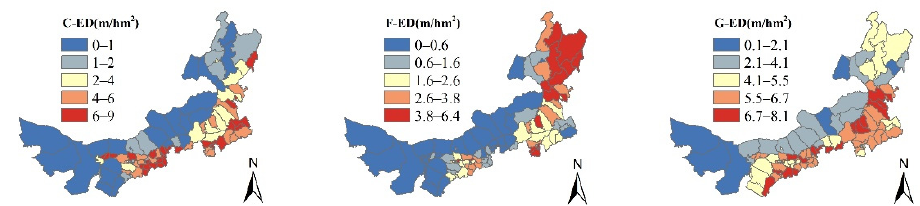
Figure 7. The spatiotemporal evolution of ED in Inner Mongolia from 2000 to 2015. Note: C, cropland; F, forestland; G, grassland; ED, edge density.